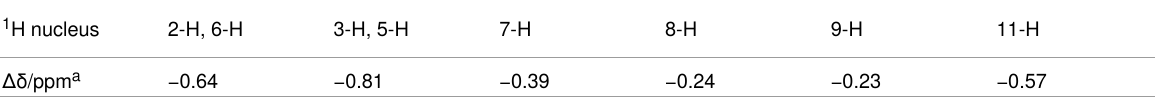
Table 2: Changes in 1 H NMR chemical shift of CPE after the addition of Q[8] (V D2O /V DCl = 3:2). 1 H nucleus